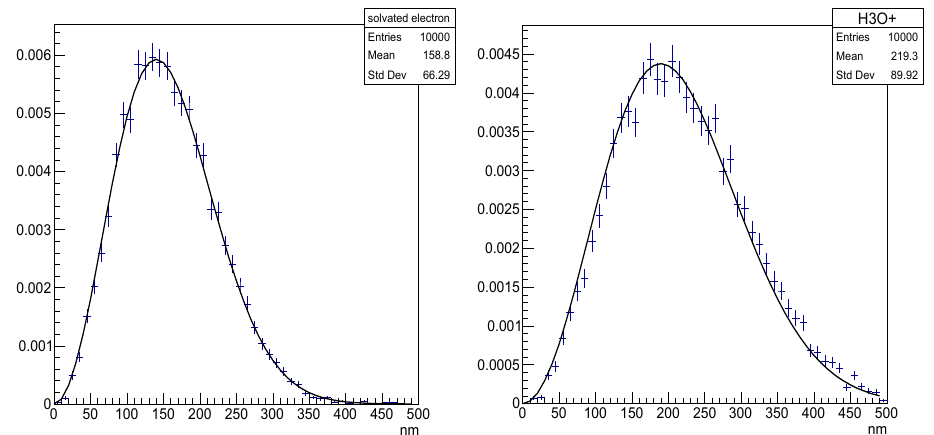
Figure 1. Diffusion range of chemical species (left plot: solvated electron; right plot: H 3 O + ) set in Brownian motion in liquid water within 1 µs simulated with Geant4-DNA (crosses) compared to the theoretical Smoluchowski solution (line).